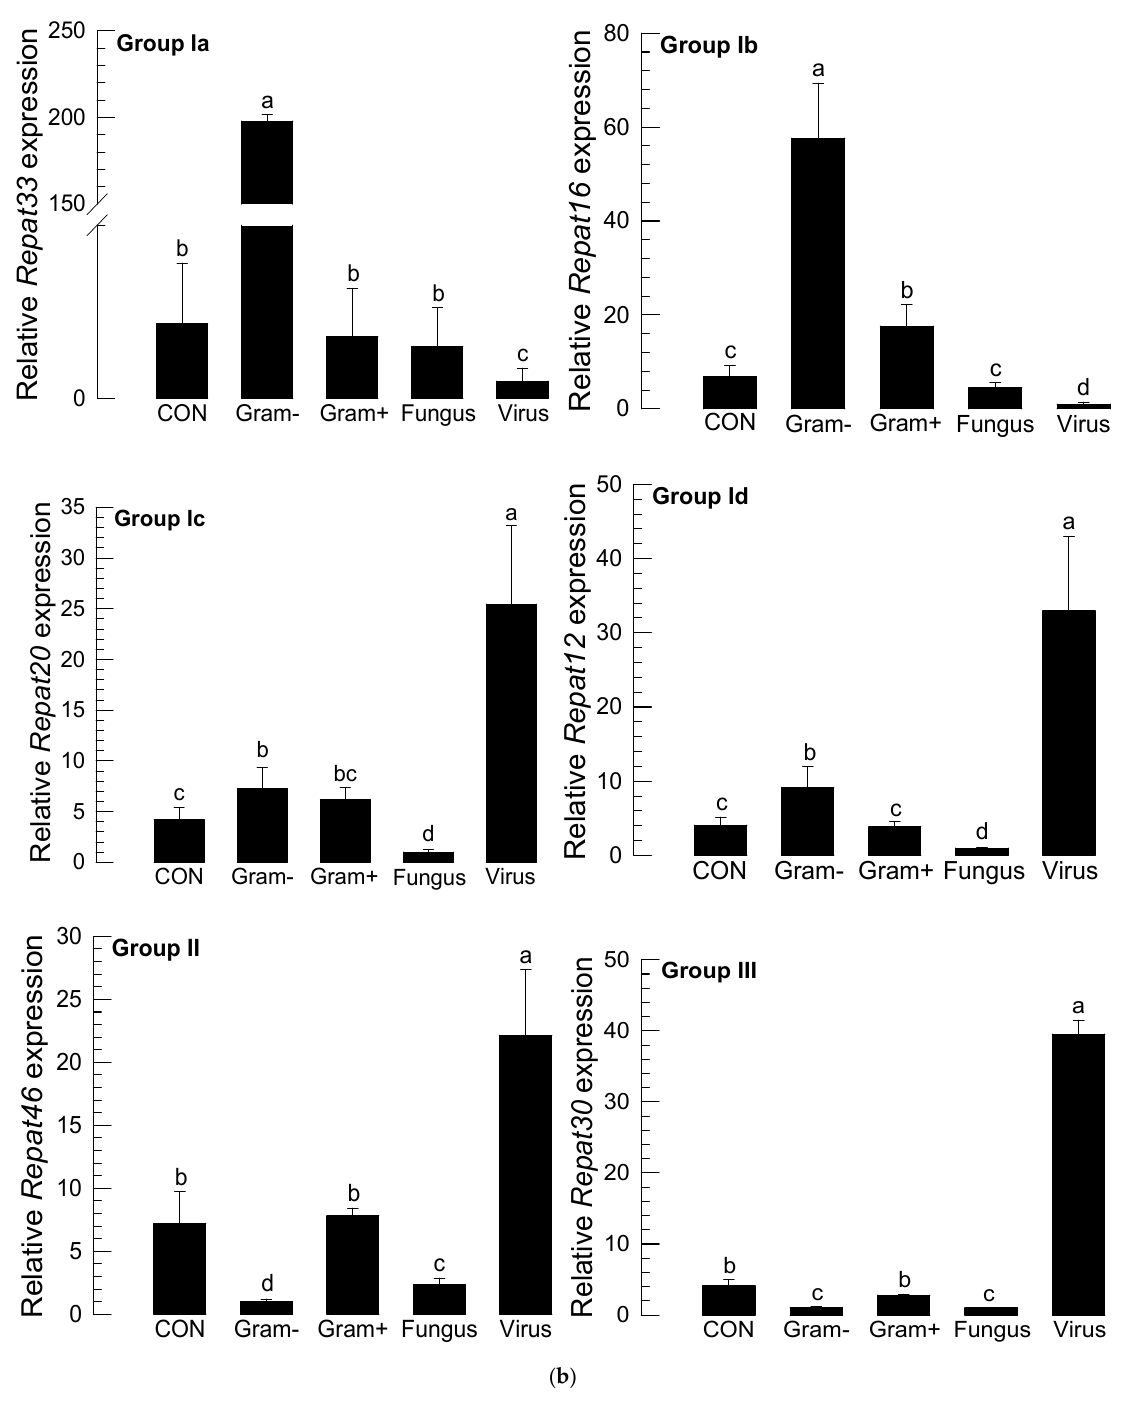
Figure 1. Classification of Repat family genes of S. exigua . ( a ) Phylogenetic analysis of 46 Repat genes. The analysis was performed using MEGA6. Bootstrapping values were obtained with 1000 repetitions to support branching and clustering. Amino acid sequences of selected genes were retrieved from GenBank with an accession number of PRJNA634227. ( b ) Expression of Repat genes induced by different pathogens. ‘Gram-’ and ‘Gram+’ represent E. coli and E. mundtii bacteria, respectively. Fungus and virus represent M. rileyi and AcMNPV, respectively. Immune challenge used a hemocoelic injection of bacteria (10 4 cells/larva), fungus (1000 conidia/larva), or virus (10 4 pfu/larva). After 8 h of incubation, total RNAs were extracted from the fat body and used for constructing cDNAs. A ribosomal gene, RL32 , was used as a reference gene for RT-qPCR. Each treatment was replicated three times with independent tissue preparations. Different letters indicate significant differences among means at Type I error = 0.05 (LSD test).